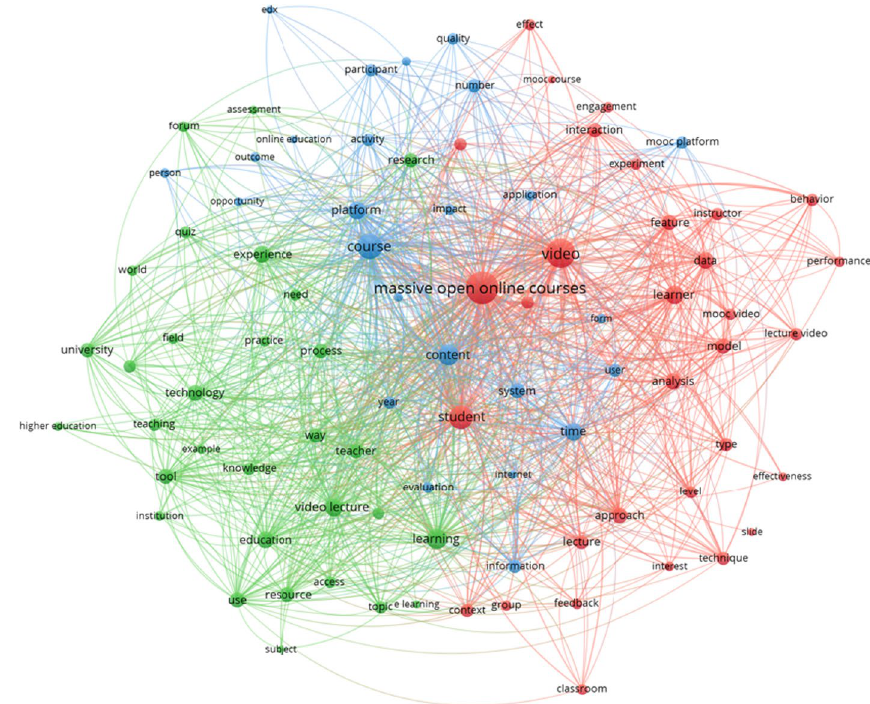
Fig. 8 Thematic cluster educational resources for MOOCs. Network map